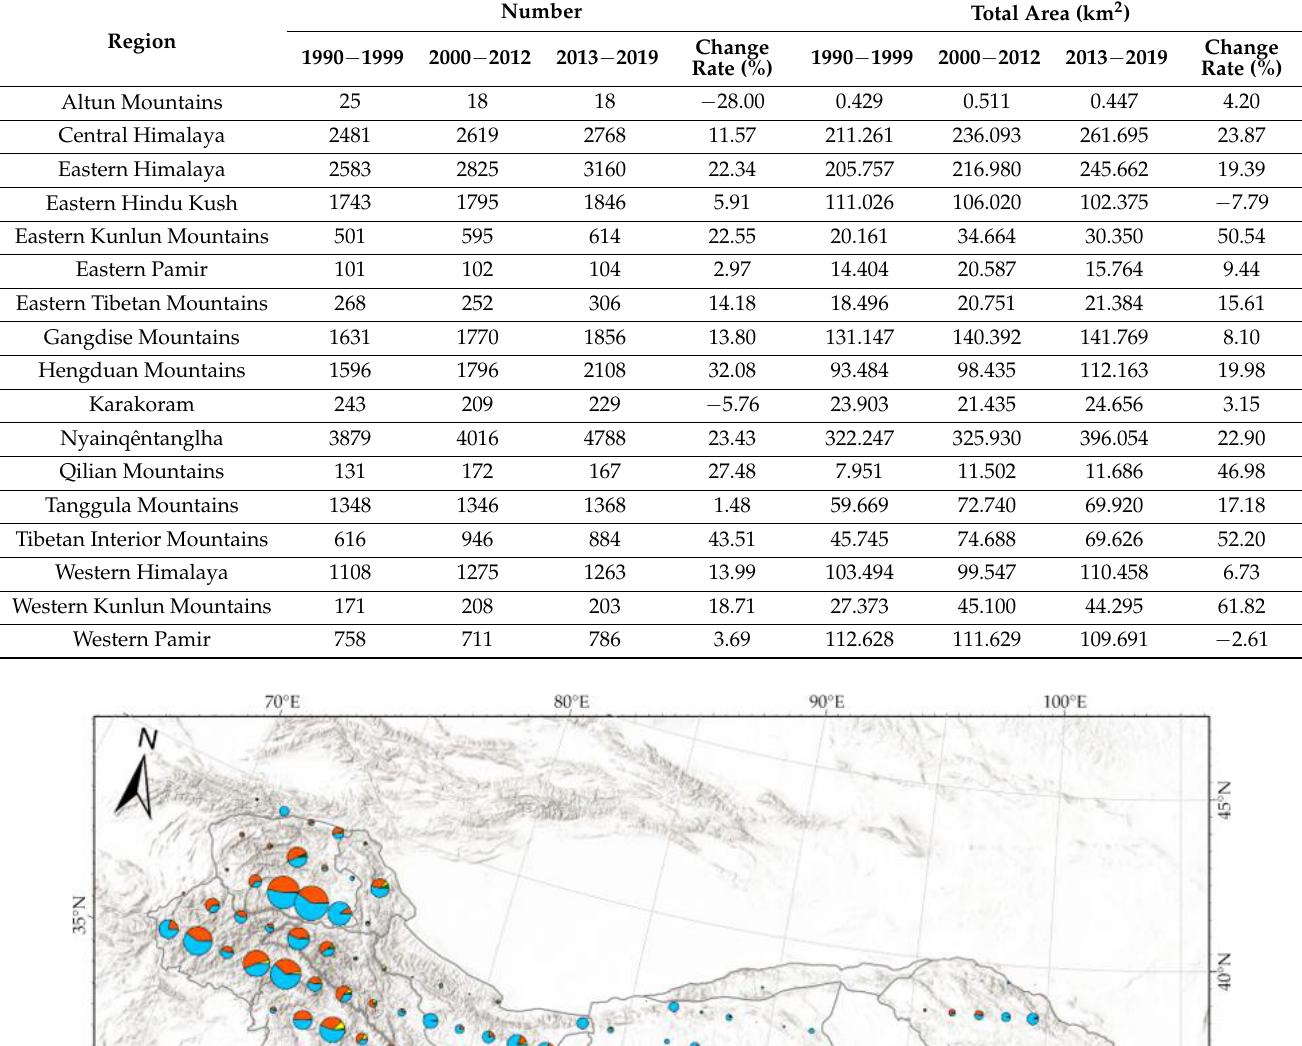
Table 1. Regional summary of lake numbers and areas in each period.